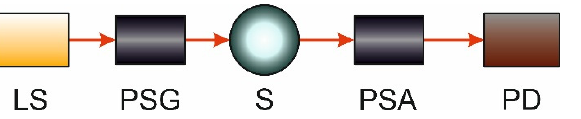
Figure 1. General block diagram of MM polarimeters: light source (LS), polarization state generator PSG, sample (S), polarization state analyzer (PSA), photodetector (PD). In general, an MM polarimeter consists of a light source (LS), a polarization state